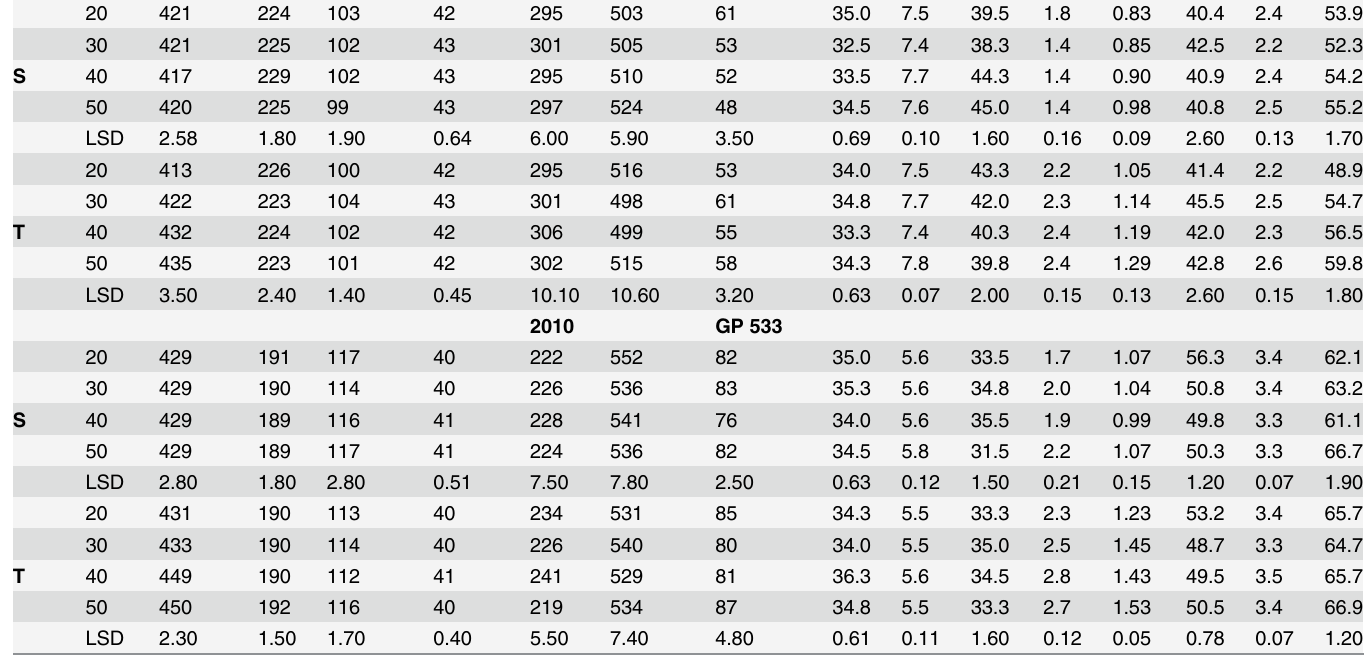
correlation was observed between SR and linolenic acid (P value ranged from 0.01 to 0.002) on sin- gle rows in 2008 and on both rows in 2009, between SR and sucrose (P value ranged from 0.03 to 0.004) on single-rows, and between SR and glucose (P value ranged from 0.04 to 0.001) on both rows in 2008 and 2009 (Table 8). Boron concentration showed a positive (P value ranged from 0.02 to < 0.0001) correlation with SR on single-row only in 94M80 in 2008 and 2009. No consis- tent correlations were observed between SR and other seed constituents in 94M80 (Table 8). In GP 533, linolenic acid concentration had a significant (P (cid:1) 0.01) correlation with SR on single- and twin-rows in 2009 in GP-533. Glucose had a positive correlation with SR on single- row only in GP 533 in 2009. Concentration of B was significantly (P < 0.05) correlated with SR in GP 533 on both row-types, but only in 2008. Phosphorus concentration had significant (P < 0.0001) correlation with SR on twin-rows only in GP 533 in 2008. There were either no correlations or inconsistent correlations observed between the remainder of the seed constitu- ents and SR on both row-types and in both soils (Table 7 and 8). When correlations were per- formed across the two cultivars, sucrose and fructose showed significant positive correlation with SR, depending on RT in clay soil (Fig 1). Similar observation was noticed for seed protein, linolenic acid, sucrose, glucose, fructose, and B in sandy soil (Fig 2). Discussion Effects of seeding rate and row-type on protein, oil, fatty acids, sugars, and minerals The increasing trend of protein and sugar concentrations in seeds, especially sucrose and glu- cose, with increased seeding rates (SR) could be due to higher nutrient uptake, transport,